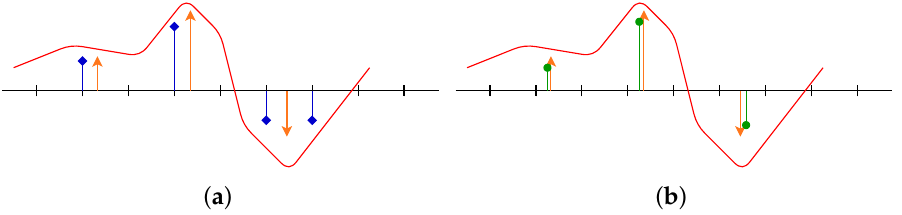
Figure 1. ( a ) Discrete reconstruction, which can be seen as spikes with support constrained on a grid; ( b ) off-the-grid reconstruction, the spikes can move continuously on the line. The red line is the acquisition y , orange spikes are the source (the cause we want to retrieve), blue spikes are discrete reconstruction constrained on a grid and green can move freely since it is off-the-grid. Note that, when a source spike is between two grid points, two spikes will be recovered in the discrete